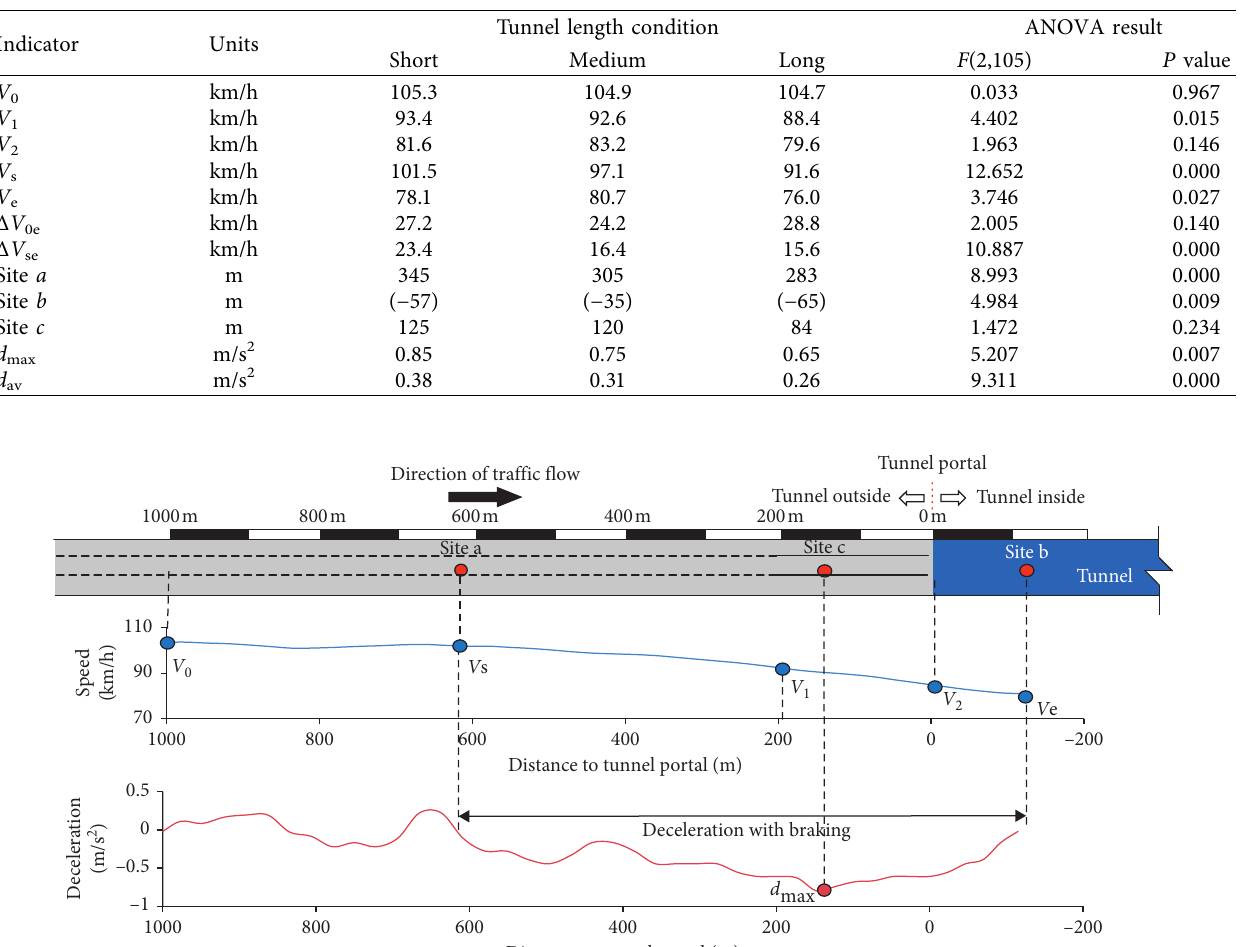
Table 2: Statistical results for driving behavior